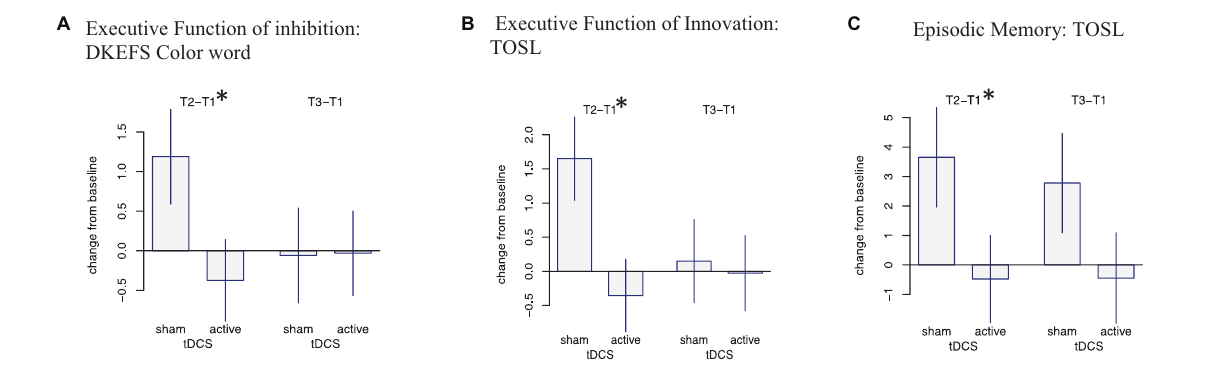
Frontiers in Neuroscience |